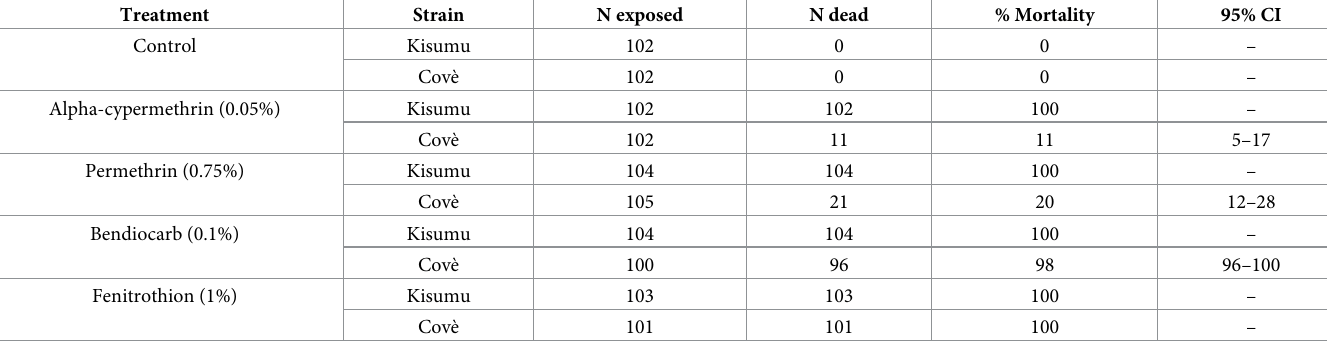
Table 1. WHO susceptibility cylinder bioassay results with Anopheles gambiae sensu lato from Cov è . Treatment